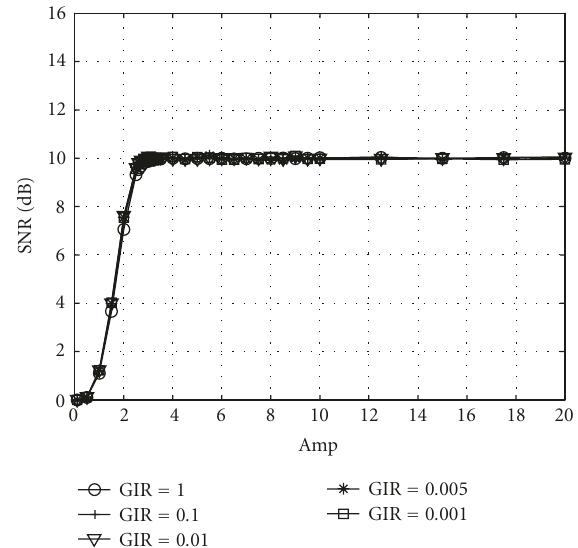
Figure 7: SNR versus Amp for various σ 2 values (rate = 1 . 0, A = 0 . 1, GIR = 0 . 1).